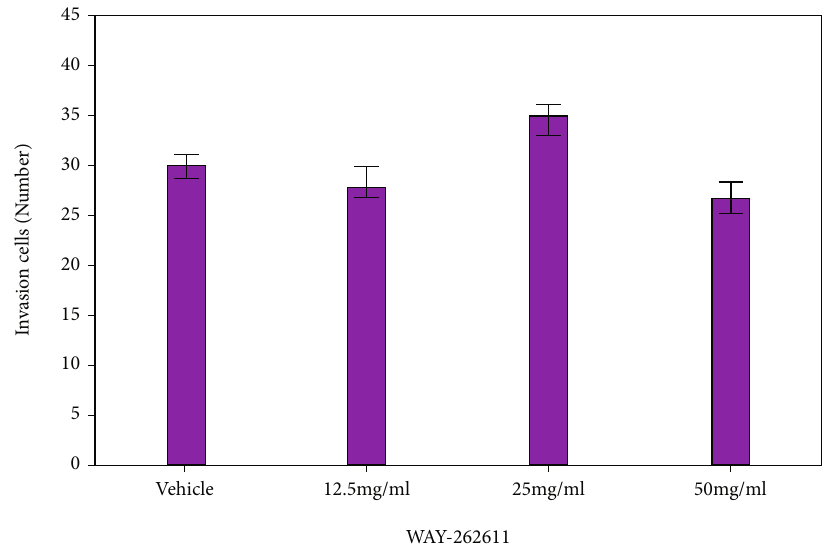
Figure 9: WAY-262611, a possible promoter of -catenin, saved HCT116 cells against HQEZ.